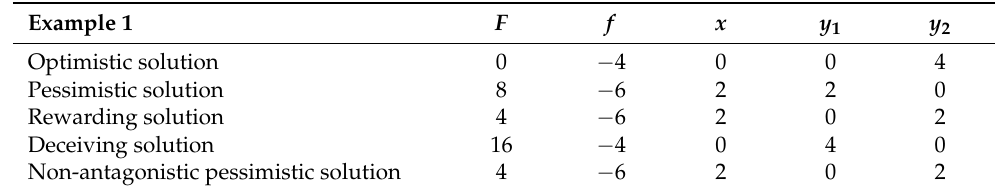
Table 1. The solutions and optimal values of Example 1.